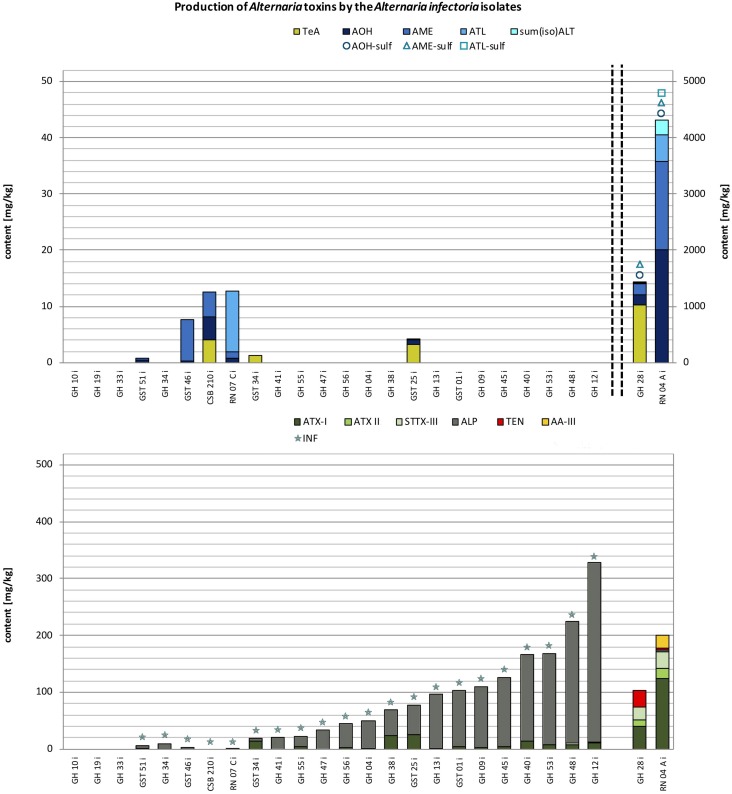
Stacked column charts – in ascending order regarding the total toxin production – of the quantitative production of tenuazonic acid (TeA), alternariol (AOH), alternariol mono methylether (AME), altenuisol (ATL) and the sum of altenuene and isoaltenuene [sum(iso)ALT] in comparison to the quantitative production of altertoxin I (ATX-I), altertoxin II (ATX-II), stemphyltoxin III (STTX-III), alterperylenol (ALP), tentoxin (TEN), and altenuic acid III (AA-III) after 14 days at 25°C in rice in mg/kg by the A. infectoria species-group isolates (please note different scaling due to differences in concentration). The detection of alternariol sulfate (AOH-sulf), alternariol mono methylether sulfate (AME-sulf), altenuisol sulfate (ATL-sulf), altenuene sulfate (ALT-sulf) or infectopyrone (INF) is marked with the respective symbol.